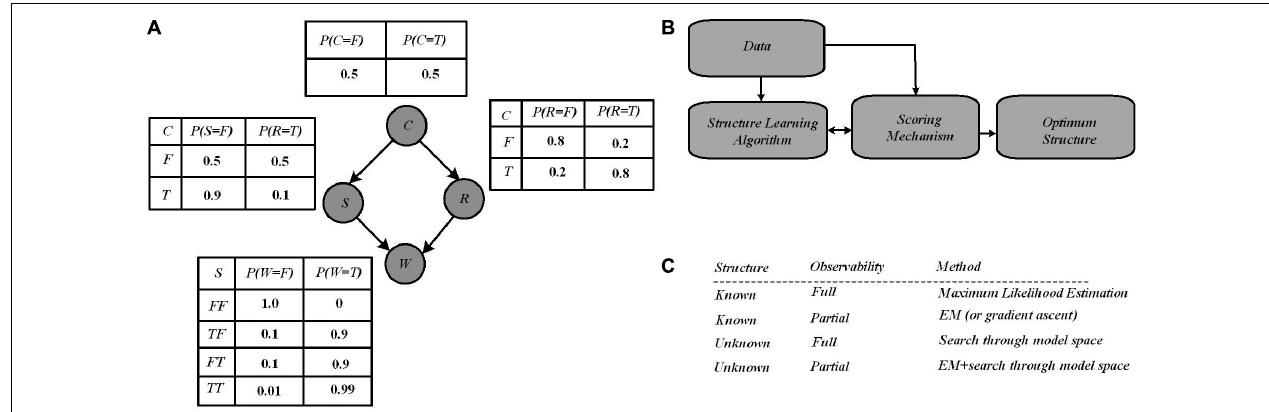
FIGURE 1 | (A) A Bayesian network with four variables where independence between variables has been reported via conditional probability tables (CPTs). All posterior probabilities of interest in this network can be computed using the laws of probability theory, notably Bayes’ rule (1) that allows inferring the causes of effects observed in the network. (B) Structure learning flow in Bayesian networks through which Learning algorithm provides graphs from data, and are scored by the scoring mechanism. Finally, an optimum structure is selected after iteratively improvements of the score over the graph structure (Kulkarni et al., 2017b). (C) Several learning case in Bayesian networks (Murphy,